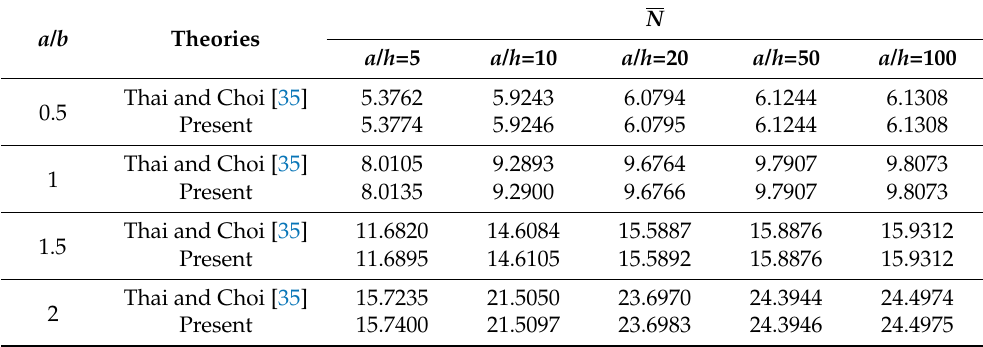
Table 2. Comparison of the dimensionless critical buckling loads for simply supported Al 2 O 3 ceramic plates ( p = k = e = 0 and R x / a = R y / b = ∞ ).